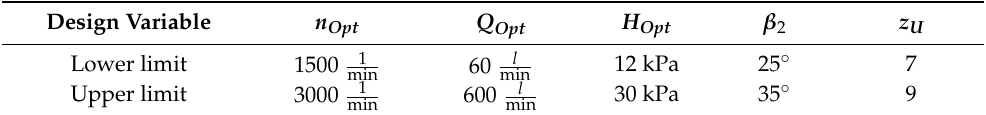
Table 2. Variation limits of the design variables.